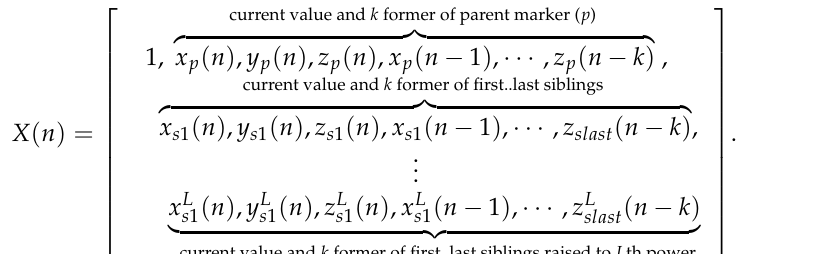
Figure 6. Performance of the two predictor models of P 4 predicted variables): ( a ) first dimension of the first marker (with artificial distortions); ( b ) residual histograms and corresponding Laplace PDFs for R 4 parameters, see Equation